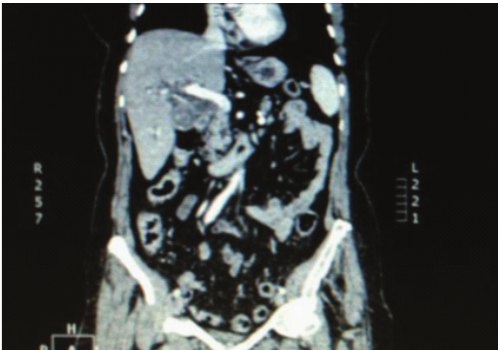
F 3: Abdominal computed tomography con�rming the ultra- sound �ndings and excluding malignancy in the porta hepatis area, in the liver, and in the pancreas.